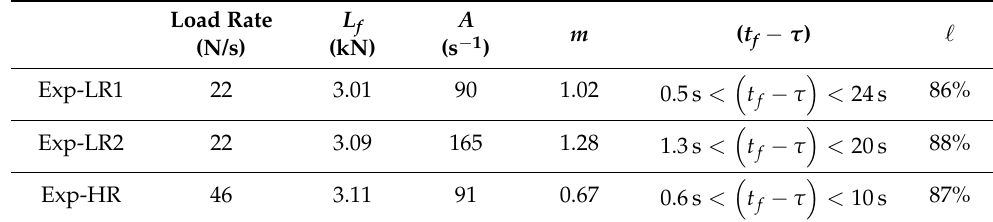
Table 2. The details of the F -function power law, F experiments.